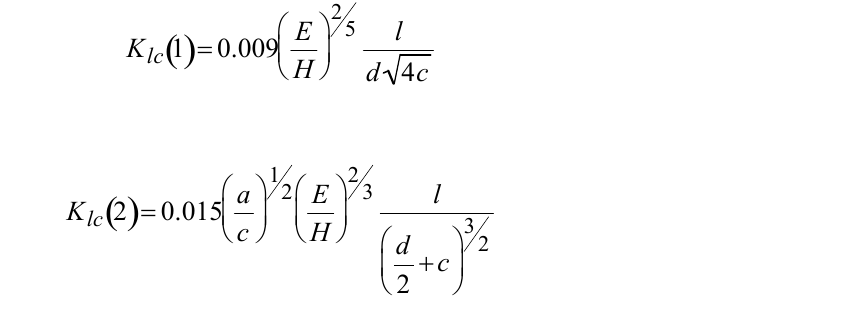
N samples annealed at 2 GPa. 3 4